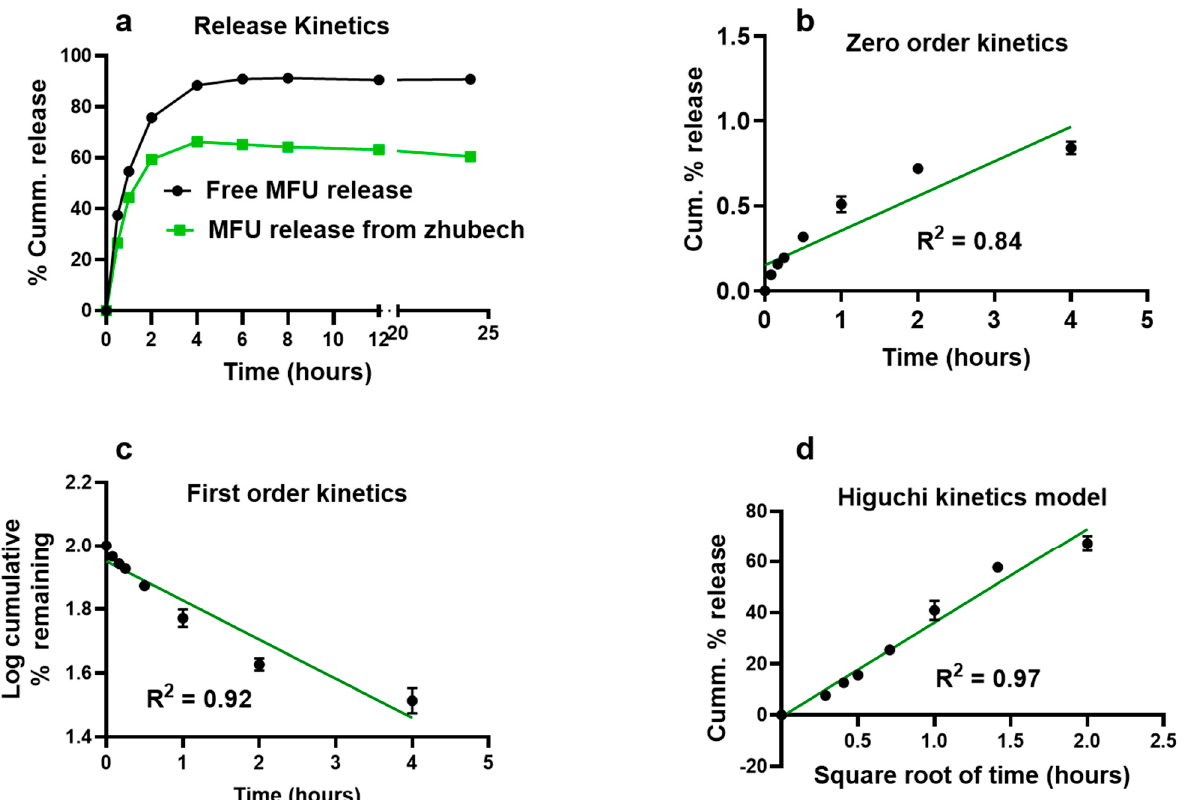
Figure 2. In vitro release kinetics of MFU from Zhubech. ( a ) In vitro cumulative release of free MFU and MFU from Zhubech at 24 h. ( b ) Release profile of MFU from Zhubech exhibiting zero-order kinetics; the release followed a non-linear pattern with R 2 = 0.84. ( c ) Release profile of MFU showing first-order kinetics; the release followed an inverse linear pattern with R 2 = 0.92. ( d ) Release profile of MFU exhibiting Higuchi release model; the release followed a linear pattern with R 2 = 0.97.